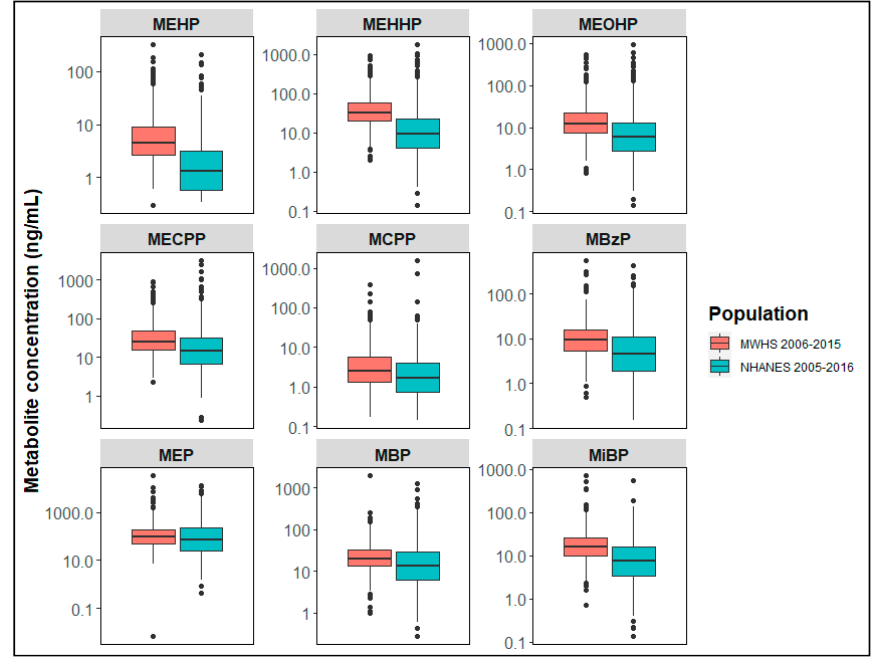
Figure 1. Midlife urinary phthalate metabolite concentrations. Box plots display urinary phthalate metabolite concentrations (ng/mL) of women in MWHS (2006–2015, n = 754) and women ages 45–54 from 6 NHANES survey cycles (2005–2016, n = 902). Concentrations were not adjusted for urine dilution. Box plots include the median (center line in box), the 25th percentile (lower line of box), and the 75th percentile (upper line in box). Numeric values for phthalate metabolite concentrations have been published elsewhere [13,23] . MEHP (mono-2-ethylhexyl phthalate); MEHHP (mono-(2- ethyl-5-hydroxyhexyl) phthalate); mono-(2-ethyl- 5-oxohexyl) phthalate (MEOHP); mono-(2-ethyl- 5-carboxypentyl) phthalate (MECPP); mono-(3-carboxypropyl) phthalate (MCPP); monobenzyl phthalate (MBzP); monoethyl phthalate (MEP); monobutyl phthalate (MBP); and monoisobutyl phthalate (MiBP); MWHS, Midlife Women’s Health Study; NHANES, National Health and Nutri- tion Examination Survey. 3.3. Associations of Phthalate Biomarker Concentrations with Prior Fibroid Diagnosis Overall, higher concentrations of some phthalate biomarkers were associated with higher risk of prior fibroid diagnosis (Table 2). In unadjusted models, women had 10–19% higher risk of prior fibroid diagnosis for every two-fold increase in Σ DEHP (RR: 1.10; 95% CI: 1.00, 1.22), MEP (RR: 1.11; 95% CI: 1.02, 1.20), MiBP (RR: 1.18; 95% CI: 1.06, 1.31), Σ PCP (RR: 1.16; 95% CI: 1.08, 1.25), Σ Phthalates (RR: 1.19; 95% CI: 1.10, 1.29), and Σ AA (RR: 1.15; 95% CI: 1.02, 1.29). Interestingly, in unadjusted models, we also observed a marginal in- verse association of MBzP with prior fibroid diagnosis (RR: 0.92; 95% CI: 0.84, 1.02). After accounting for important confounders, only associations of Σ DEHP, Σ Phthalates, and Σ AA with fibroids remained. Women had a 9–16% higher risk of prior fibroid diagnosis, respectively, for every two-fold increase in Σ DEHP (RR: 1.13; 95% CI: 1.02, 1.26), Σ Phthalates (RR: 1.09; 95% CI: 1.00, 1.19), or Σ AA (RR: 1.16; 95% CI: 1.03, 1.31). In adjusted models, we also observed a marginal association with Σ Plastics, where women had a 12% (RR: 1.12; 95% CI: 1.00, 1.25) higher risk of prior fibroid diagnosis for every two-fold in- crease in Σ Plastics.